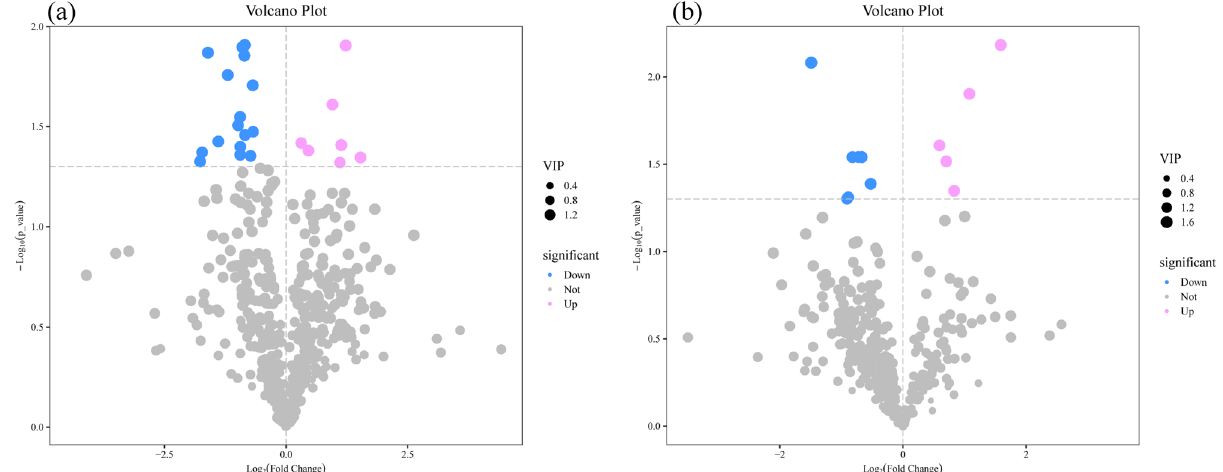
Figure 5. Volcano plots of differential metabolites were derived from ( a ) positive ion (POS) and ( b ) negative ion (NEG) modes. Each point represents a metabolite, and the point size represents the VIP value of this metabolite in the orthogonal projections to latent structures–discriminant analysis (OPLS-DA) model. Red dots indicate significantly upregulated metabolites (VIP > 1 and P < 0.05). Blue dots indicate significantly downregulated metabolites (VIP > 1 and P < 0.05). Gray dots indicate no significant difference pre/post autotomy of the siphon in Solen grandis (VIP ≤ 1 or P ≥ 0.05).